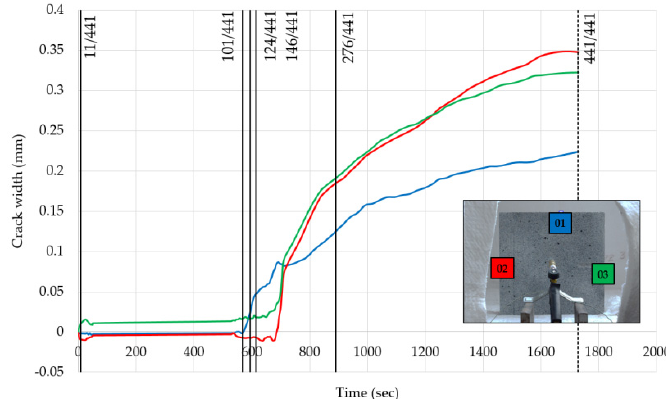
Figure 14. Evolution of crack width for the specimen with a size of 200 × 200 mm.